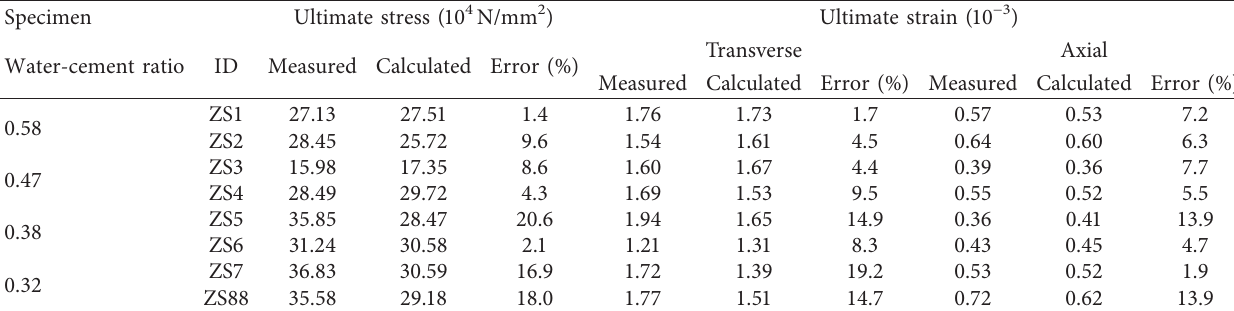
Table 6: Comparisons between the model prediction results and the experimental data.